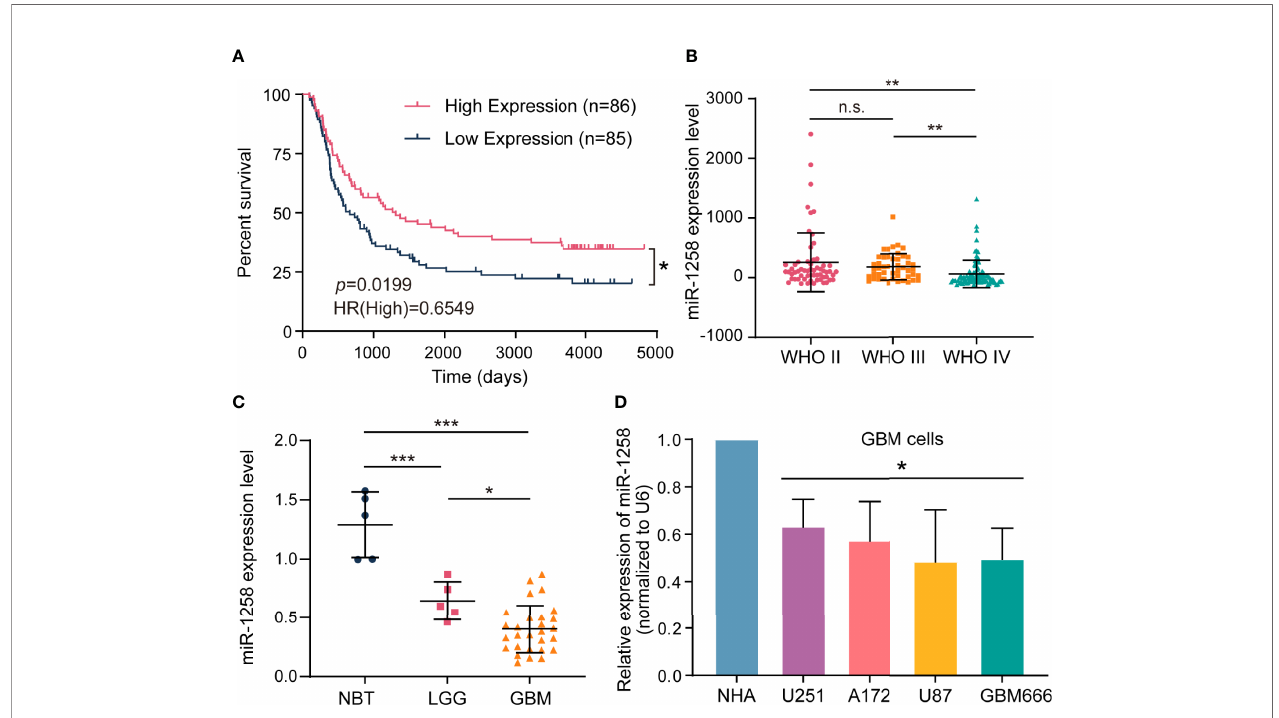
FIGURE 1 | Low expressions of miR-1258 propose an unfavorable prognosis in glioma patients. (A) The Kaplan – Meier curve of overall survival with log ‐ rank test strati fi ed by the miR-1258 level (high and low expression divided by the median expression level) in all grades of gliomas in the CGGA database; *p < 0.05 between indicated groups. (B) Relative miR-1258 expressions in WHO II, WHO III and WHO IV glioma patients were calculated using the CGGA database; **p < 0.01, n.s., no signi fi cance between indicated groups. (C) The expressions of miR-1258 in 5 NBT, 5 LGG, and 28 GBM tissues were analyzed by qRT-PCR, *p < 0.05, ***p < 0.001 between indicated groups. (D) miR-1258 expressions were detected in normal human astrocytes (NHA), three GBM cell lines (U251, A172, U87), and GBM666 primary GBM cells by qRT-PCR, *p < 0.05 when compared to